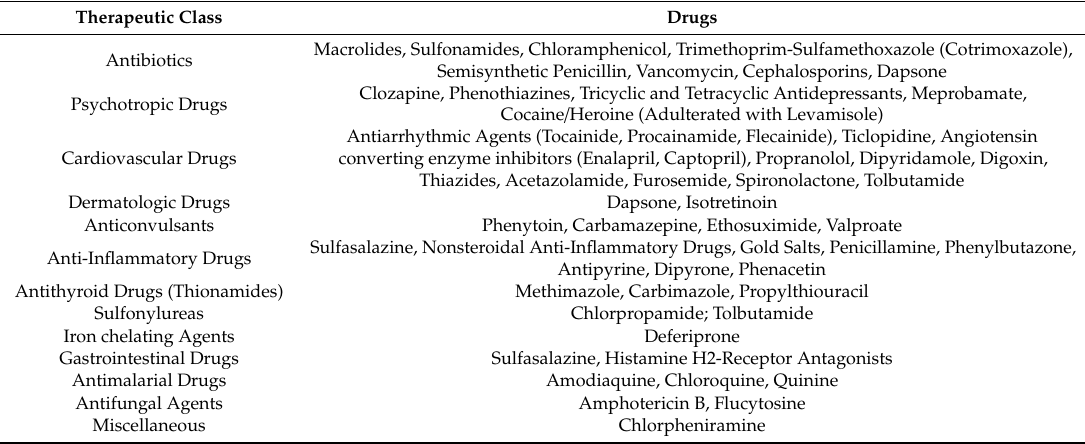
Table 1. Major medications with a definite association with